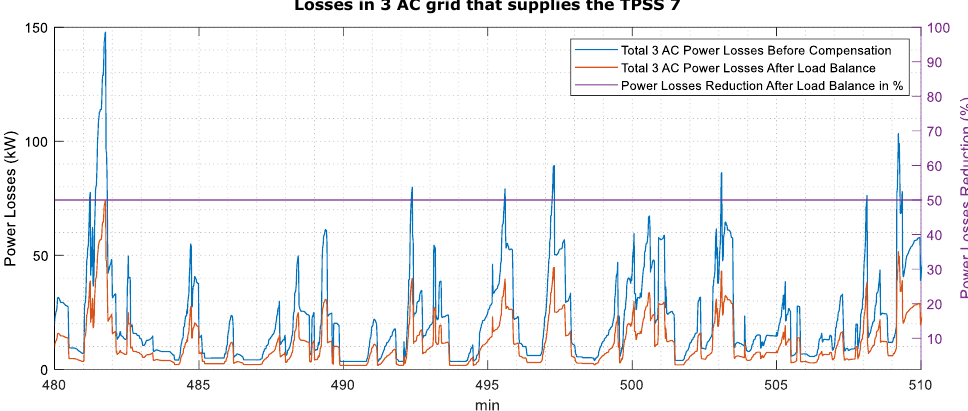
Figure 11. Power losses in the three-phase grid supplying substation